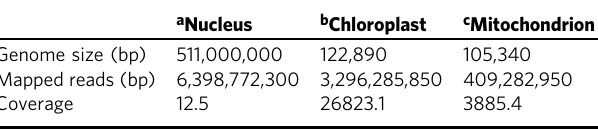
Table 1 Sequencing data for genome analysis of WT Physcomitrella patens .